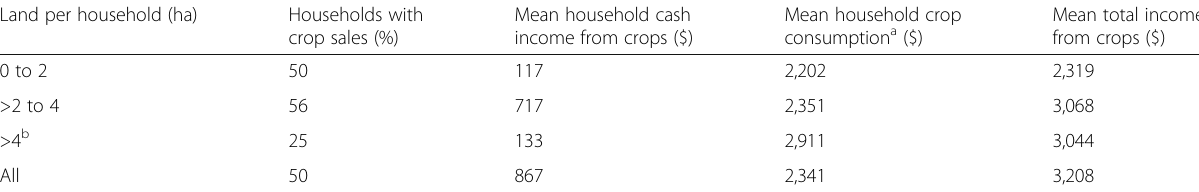
Table 2 Household crop income Land per household (ha) Households with